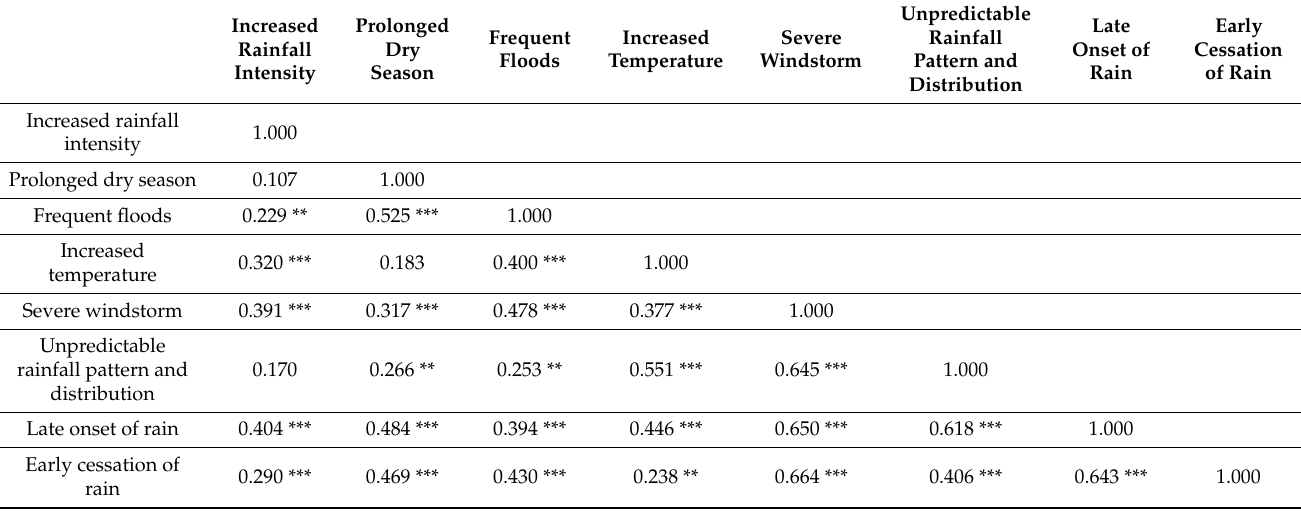
Table 3. Interdependency of the perceived climate